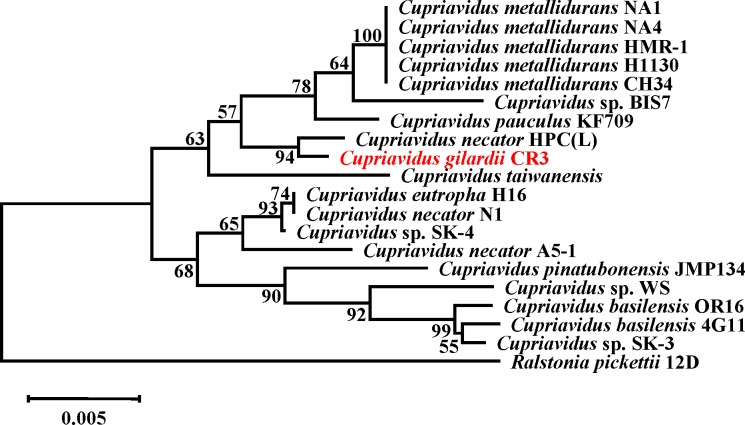
Rooted phylogenetic tree based on 16S rRNA gene sequence similarity of the genus Cupriavidus.Cluster analysis was based upon the neighbour-joining method with Ralstonia pickettii 12D as the outlier. The scale bar represents 5‰ sequence divergence. Numbers at branch-points are percentages of 1000 bootstrap resamplings that support the tree topology.